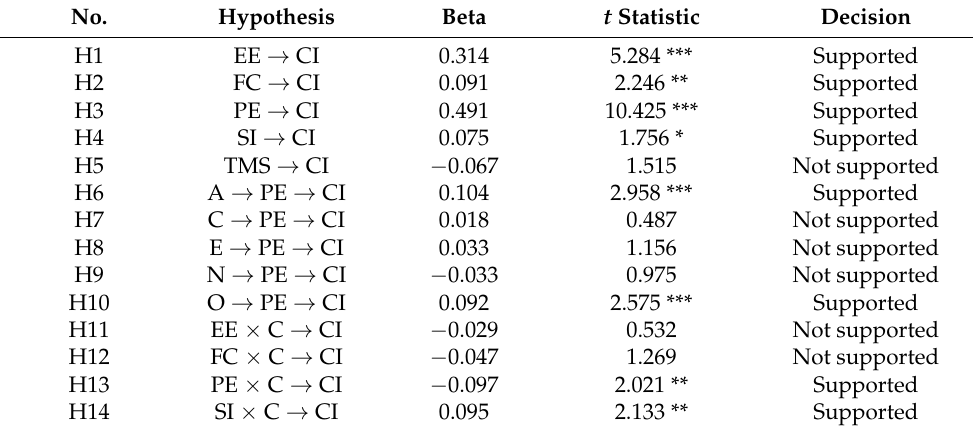
Table 8. Results